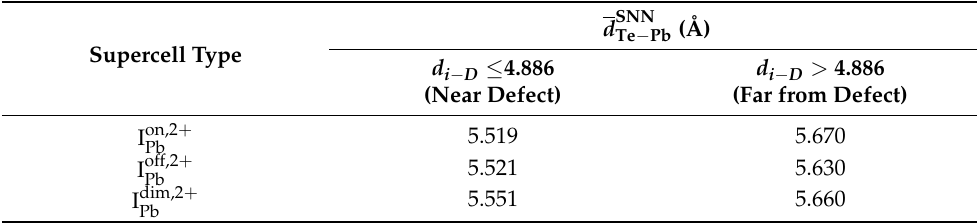
SNN Table 2. Values of d Te − Pb of host Pb atoms with d i − D interstitial defects of I on,2 +